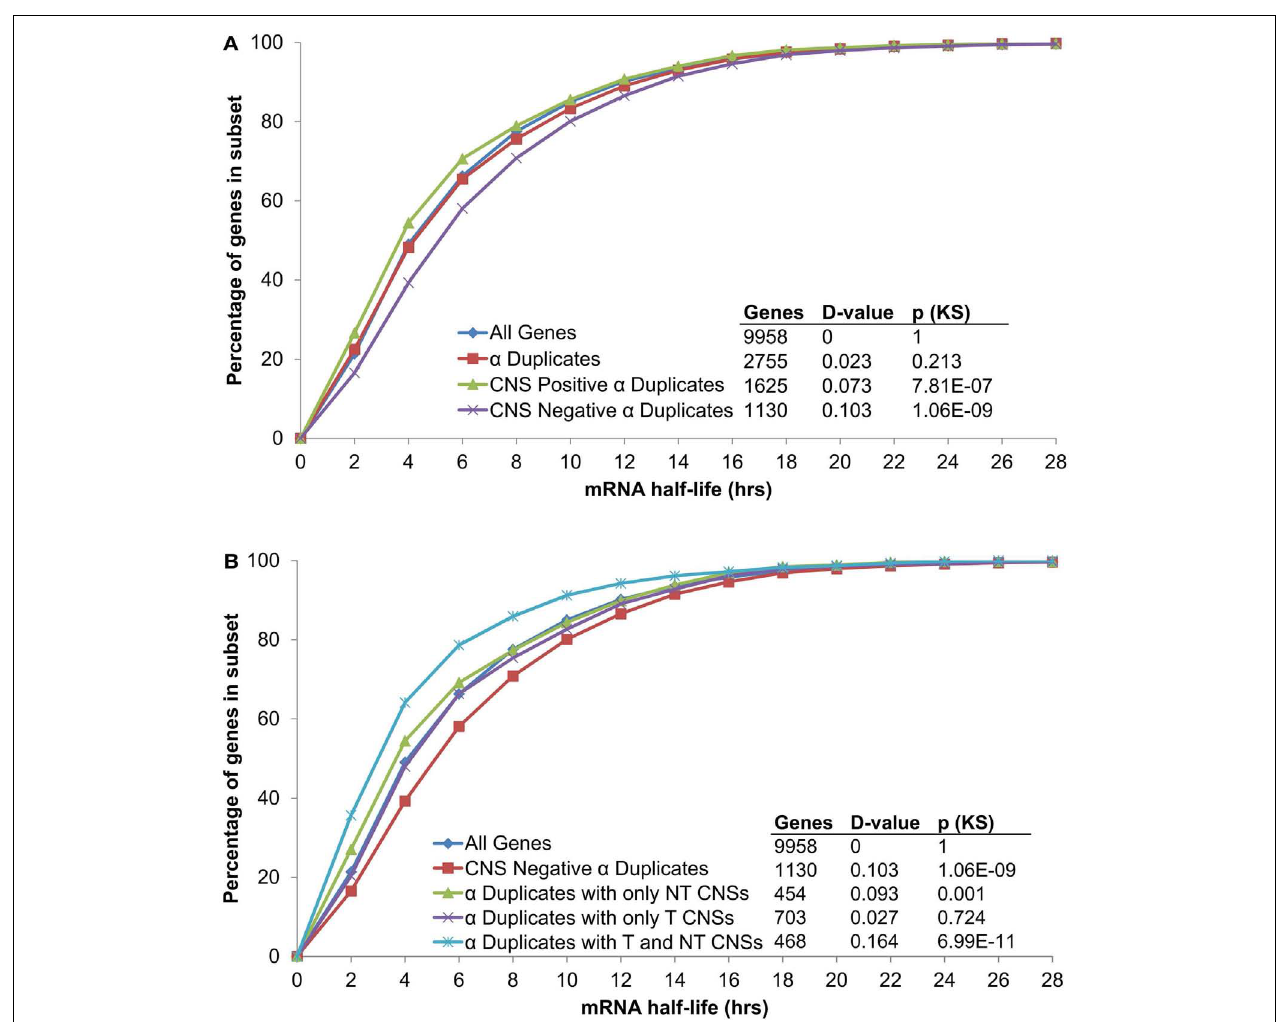
represents the distance between the distributions and was used in the Kolmogorov–Smirnov (KS) statistic to determine statistical difference. CNS, conserved non-coding sequence; NT, non-transcribed;T,